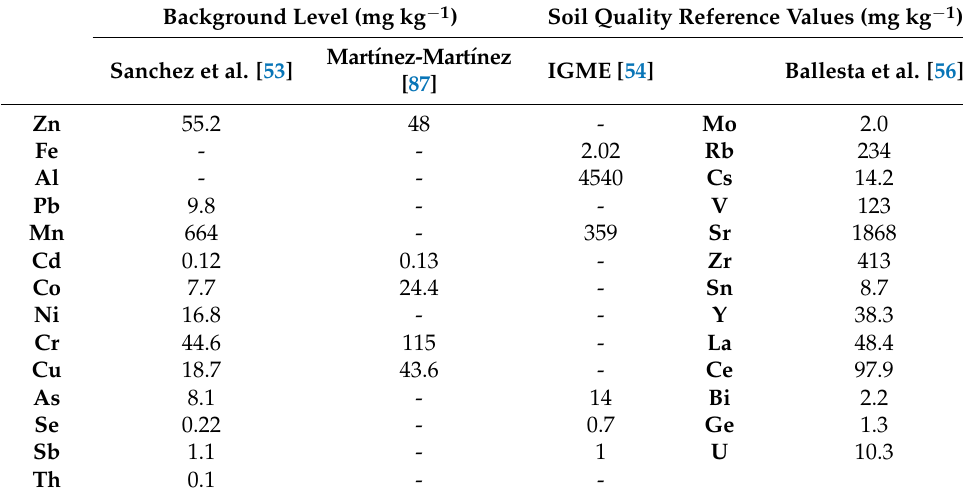
Table 7. Reference concentrations of 27